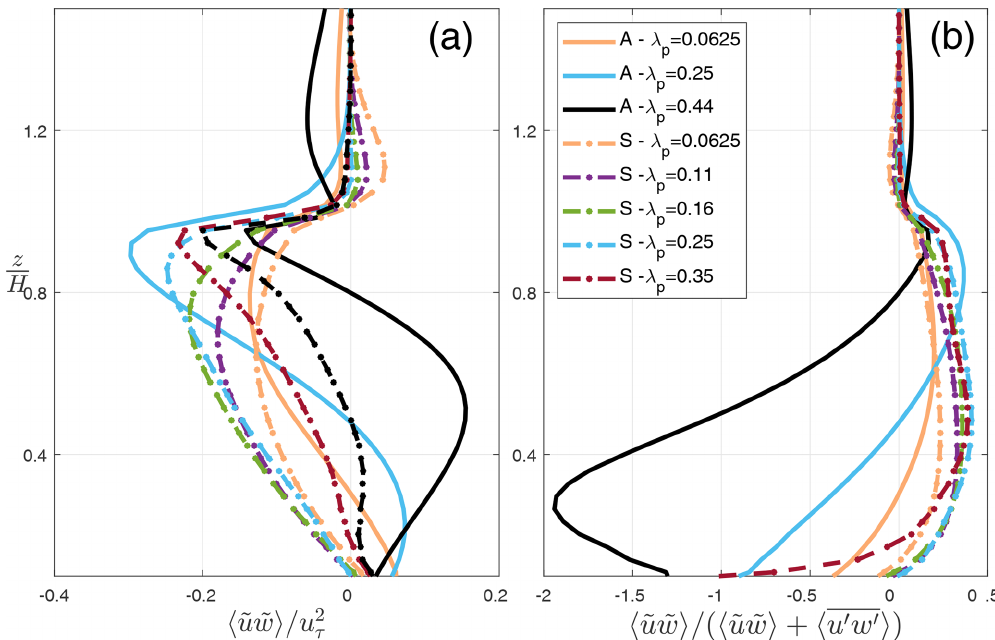
Figure 7. (a) Vertical (spatially and temporally averaged) profiles of normalized dispersive stress (cid:104)˜ u ˜ w (cid:105) /u 2 τ and (b) the contribution of dispersive stress to the total turbulent momentum flux (cid:104)˜ u ˜ w (cid:105) / stands for “staggered”.